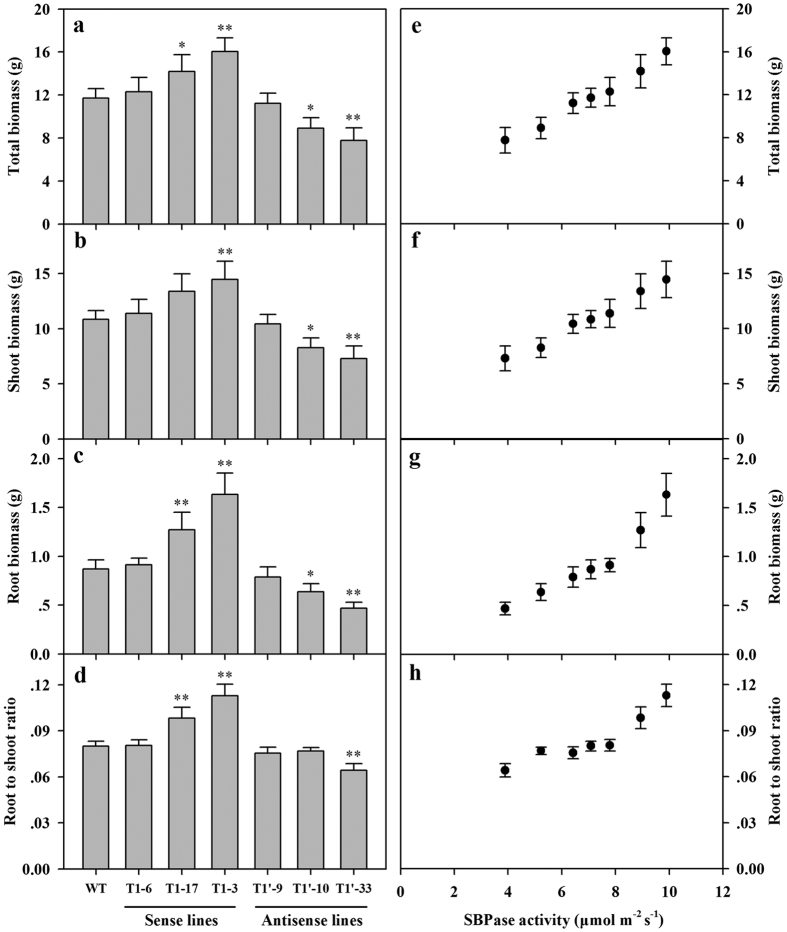
Biomass of SBPase sense and antisense tomato plants.All measurements were done on 12-leaf wild-type and T1 progeny of transgenic tomato plants. (a) Total plant biomass. (b) Shoot biomass. (c) Root biomass. (d) Root/shoot ratio. (e) Total biomass as a function of SBPase activity. (f) Shoot biomass as a function of SBPase activity. (g) Root biomass as a function of SBPase activity. (h) Root to shoot ratio as a function of SBPase activity. The results are the means ± SDs (n = 6). Asterisks indicate significant differences between WT and transgenic plants (* for P < 0.05; ** for P < 0.01).